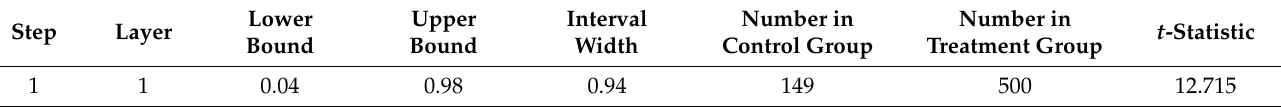
Table 4. The t -statistic calculation results of all samples.